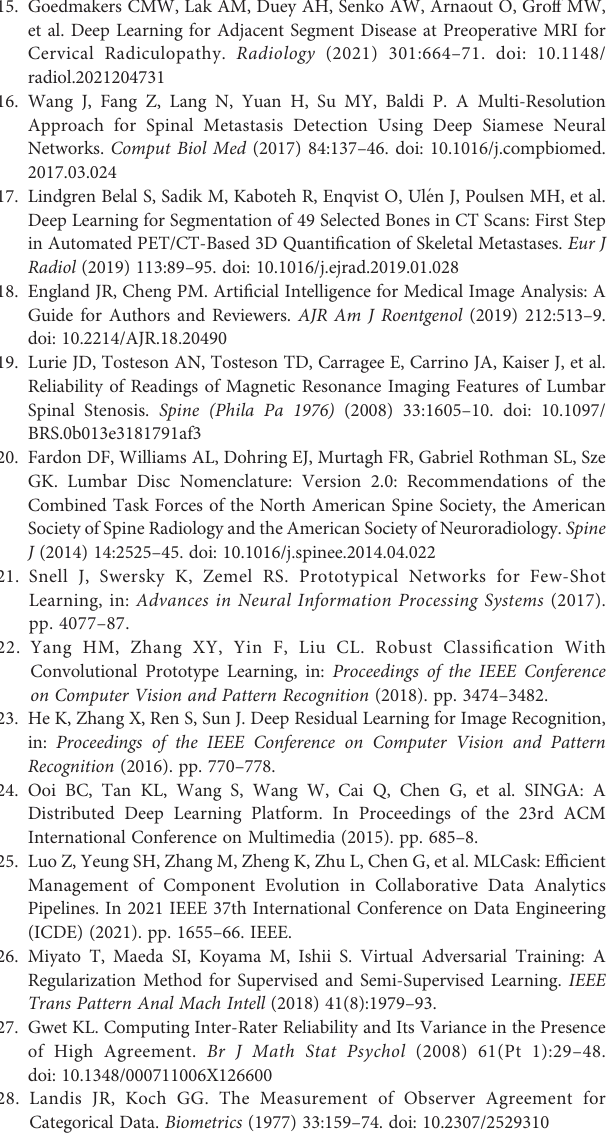
studies were performed in the supine position with a torso coil. Supplementary Table 2 | Ablation study on the developed model. Supplementary Table 3 | Comparison study on the developed model. Supplementary Table 4 | Confusion matrix of the deep learning model on the internal test set. Supplementary Table 5 | Confusion matrix of the deep learning model on the external test